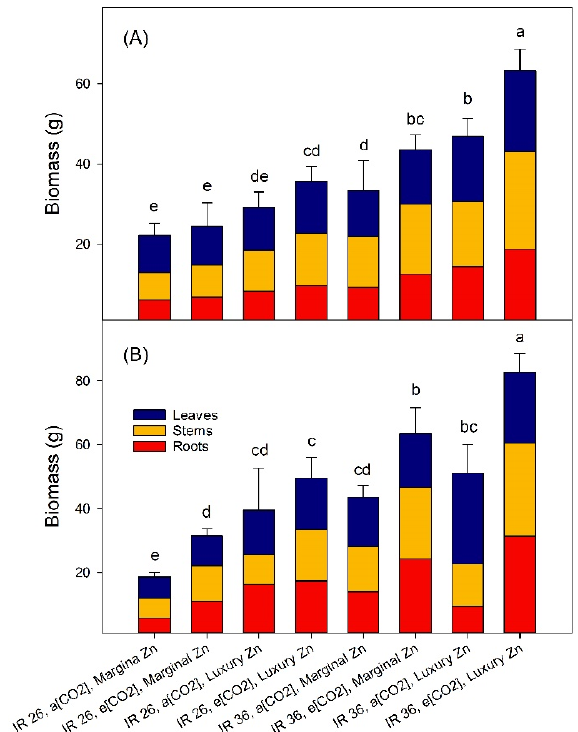
Figure 1. Treatment effects on the mass of leaves, stems and roots (vegetative biomass) at: ( A ) pan- icle emergence, and ( B ) maturity. Data are means of three replicates, the bars represent standard errors, and columns headed by different letters differ significantly ( p < 0.05). For ANOVA see Tables S2 and S3.